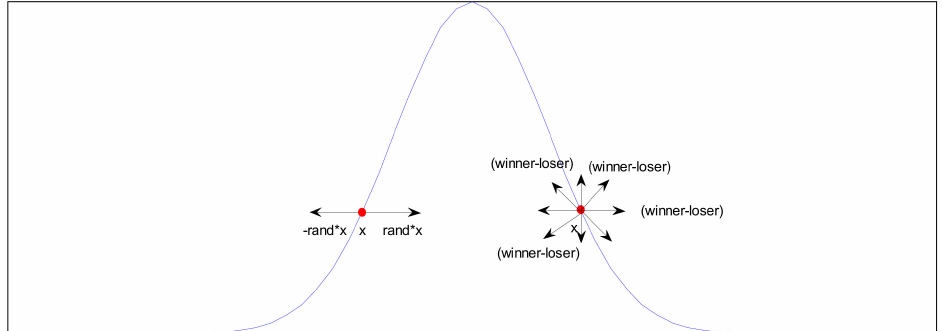
Figure 5. The search direction for different updating